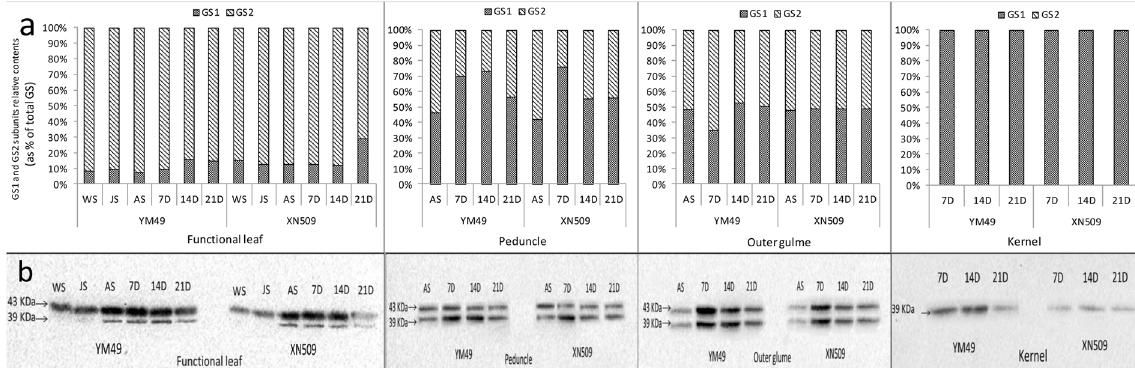
Figure 5. Western blot analysis of GS isozymes expression and dynamic changes in various organs under N −